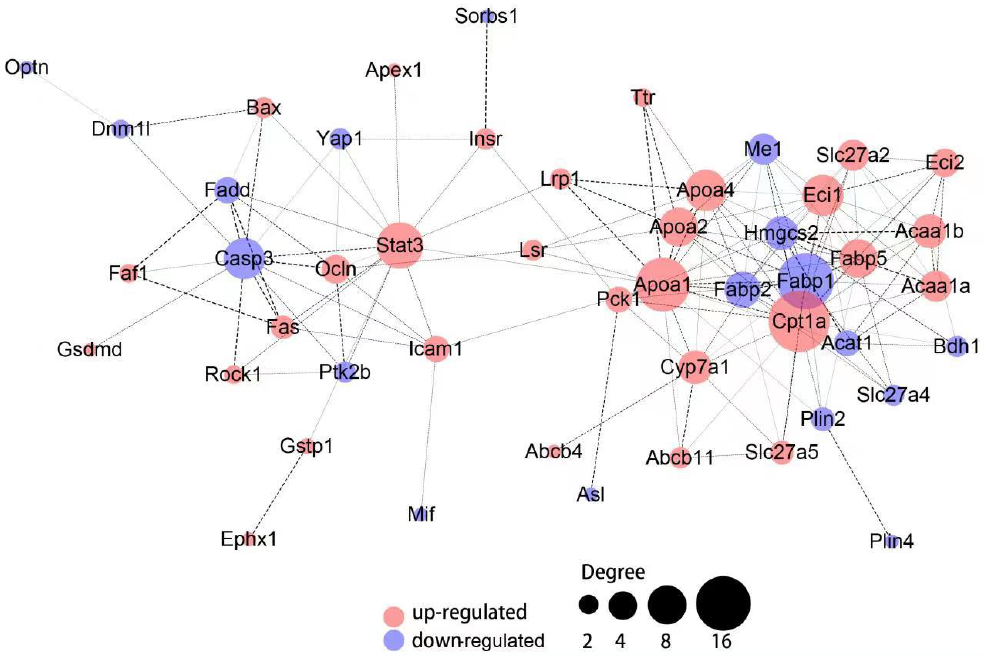
Figure 9. PPI analysis of the enriched proteins involved in lipid metabolism and inflammation under the treatment of Torularhodin. The width of the edge between the nodes represents the combined score from experimental, database annotated and data mining, the node degree represent the number of connected nodes.